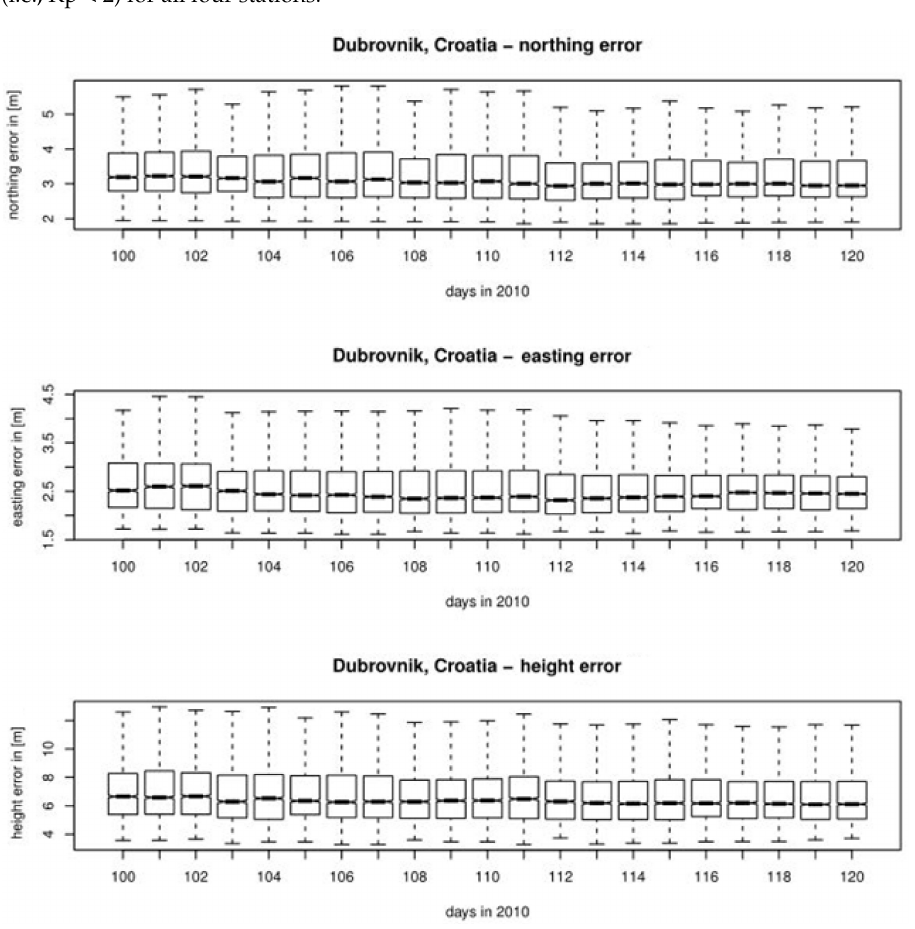
Figure 6. Box-and-whisker plot of GPS positioning errors as observed at Dubrovnik, Croatia reference station during days 100–120 in